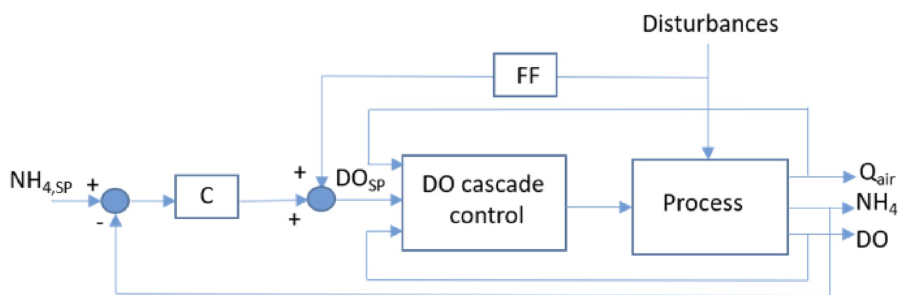
Figure 4. Ammonium-based control: feedforward-feedback control.